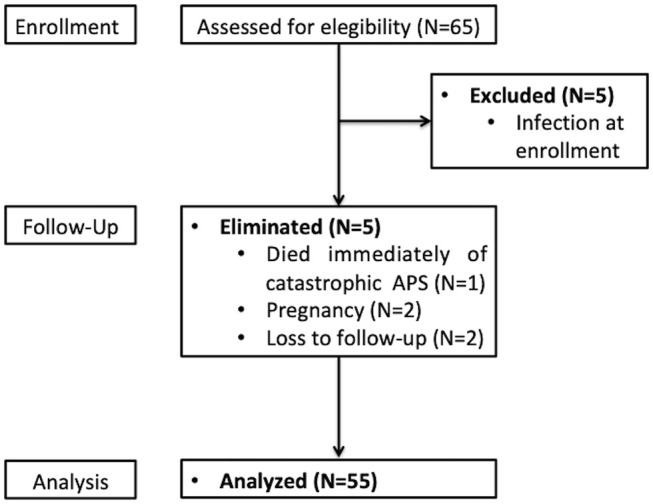
Flowchart of patient enrollment, follow-up, and analysis.